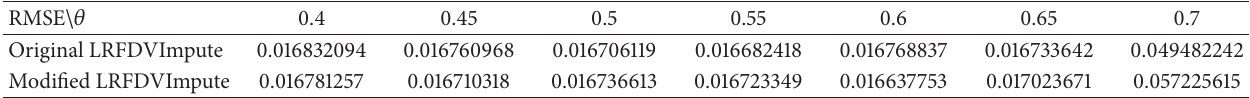
Table 3: Results for missing value estimation algorithm (Spellman, cdc15).